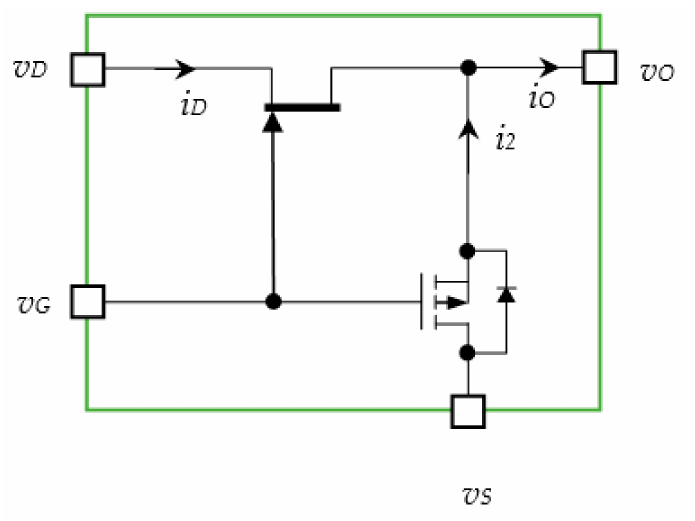
Figure 7. P-Cascode GaN HEMT Module.